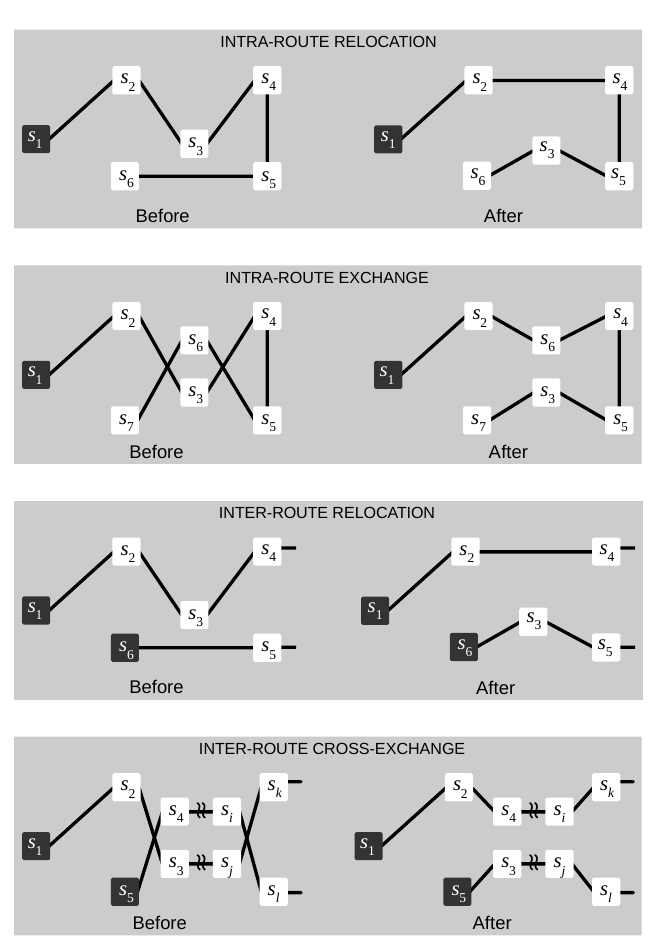
Figure 9. Local search procedures: intra-route relocation, intra-route exchange, inter-route relocation and inter-route